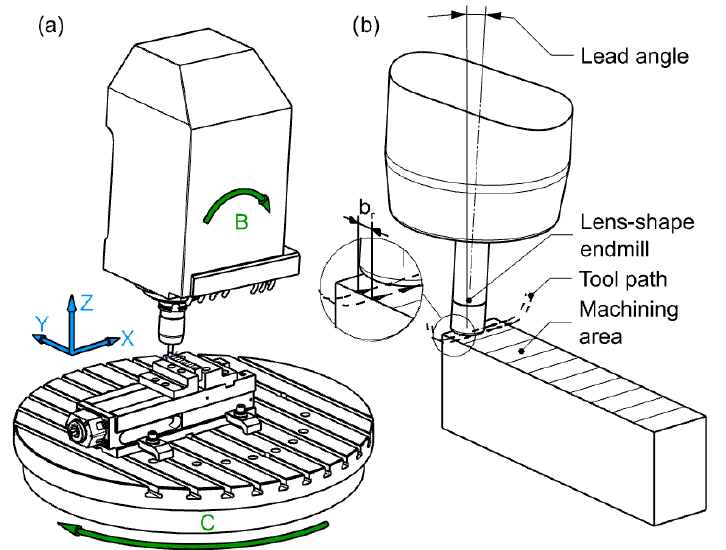
Figure 6. Scheme of ( a ) machine tool configuration with degrees of freedom along the X, Y and Z axes as well as rotational degrees of freedom B and C, carried out by the table or the head of the machine tool and ( b ) lens-shaped end mill